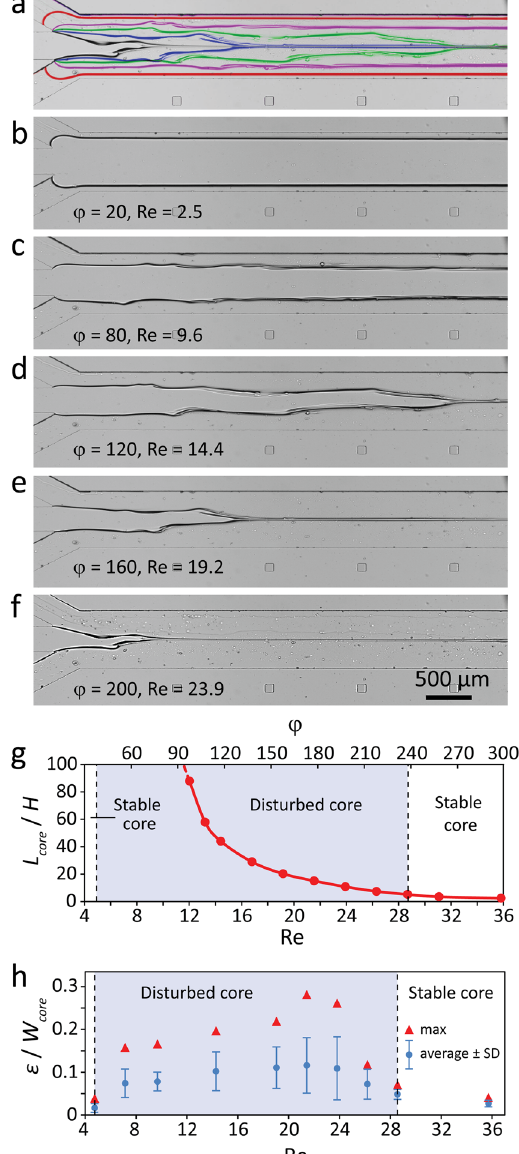
Figure 4. Formation of ‘disturbed core’ structures obtained by applying glycerol at 5 µ l/min while applying water at varying flow rates of 10 to 1200 µ l/min: ( a ) Stacked images obtained at various sheath flow rates, ( b – f ) Individual images obtained at various sheath flows corresponding to Reynolds numbers of 2.5, 9.6, 14.4, 19.2 and 23.9, showing the transition from ‘stable core’ to ‘disturbed core’ regime associated with intensified ‘interfacial waves’ at the interface of core-sheath flows, ( g ) Variations of core length ratio against Reynolds number and sheath/core flow ratio, and ( h ) Variations of core roughness ratio at the interface of core-sheath flows induced by ‘interfacial waves’ against Reynolds